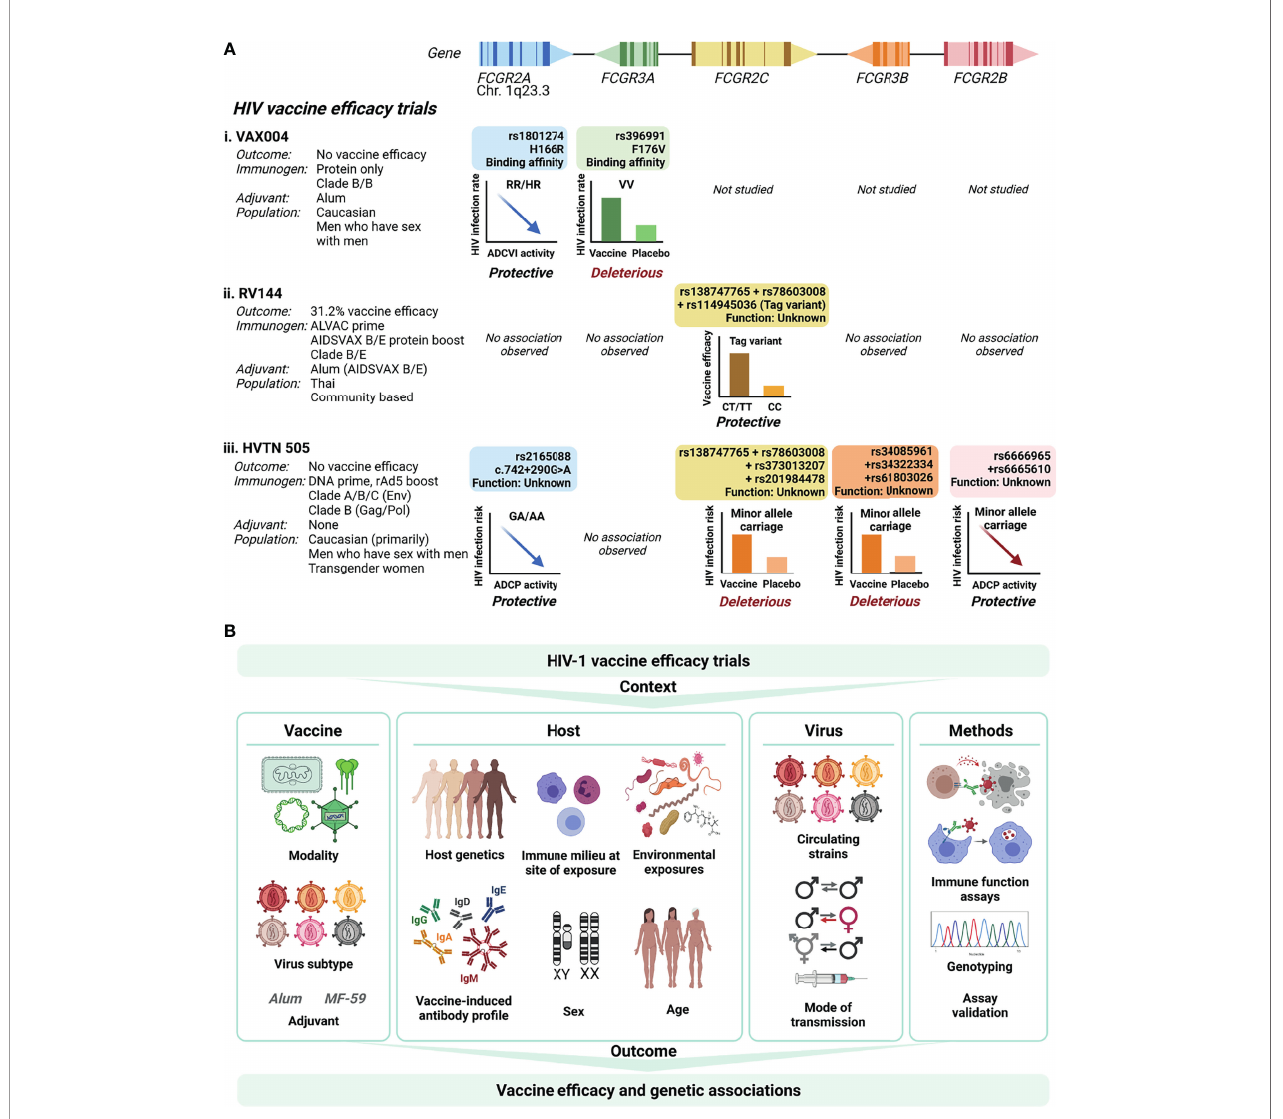
FIGURE 2 | FCGR variant associations with HIV-1 vaccine ef fi cacy trial outcomes. (A) To date, three HIV-1 vaccine ef fi cacy trials investigated the association between FCGR variants and HIV-1 acquisition risk: VAX004, RV144 and HVTN505. The trials differed with regard to vaccine modalities, target HIV-1 subtypes, study populations, mode of HIV-1 transmission, and host ethnicities. In VAX004 and HVTN505 vaccinees bearing minor alleles within FCGR2A and FCGR2B , enhanced Fc-mediated effector functions [antibody-dependent cellular viral inhibition (ADCVI) and antibody-dependent cellular phagocytosis (ADCP), respectively] associated with reduced risk of HIV-1 acquisition. In VAX004, enhanced HIV-1 acquisition occurred in vaccinees homozygous for the Fc g RIIIa-176V allele. Co-inherited intragenic minor alleles in FCGR2C enhanced vaccine ef fi cacy in RV144, but increased HIV-1 acquisition risk in HVTN505. Similarly, co-inherited minor alleles in the 5 ’ untranslated region of FCGR3B associated with HIV-1 acquisition risk in HVTN505. (B) De fi ning FCGR genetic associations with HIV-1 vaccine ef fi cacy is affected by several factors relating to the vaccine, the host, the virus and methodology used. Created with